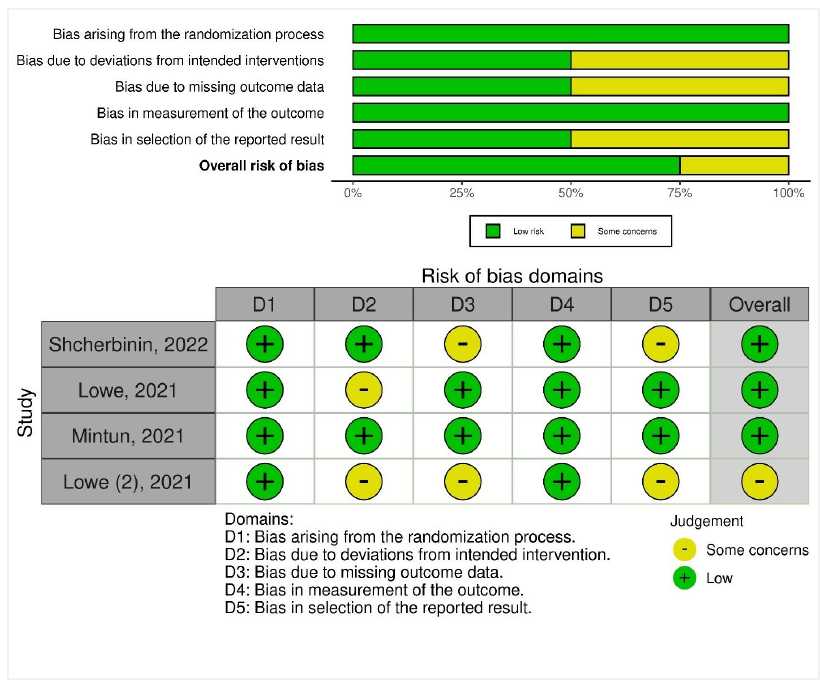
Figure 2. Risk-of-bias assessment of RCTs using the ROB-2 tool. Traffic light plot of study-by-study bias assessment. Weighted summary plot of the overall type of bias encountered in all studies.